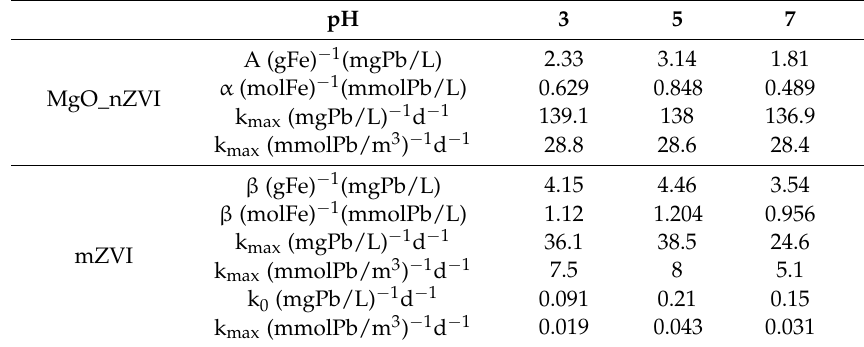
Table 1. Kinetic parameters obtained through the interpolation, by means of Equations (15) and (16), of k obs values expressed as function of the Fe/C i